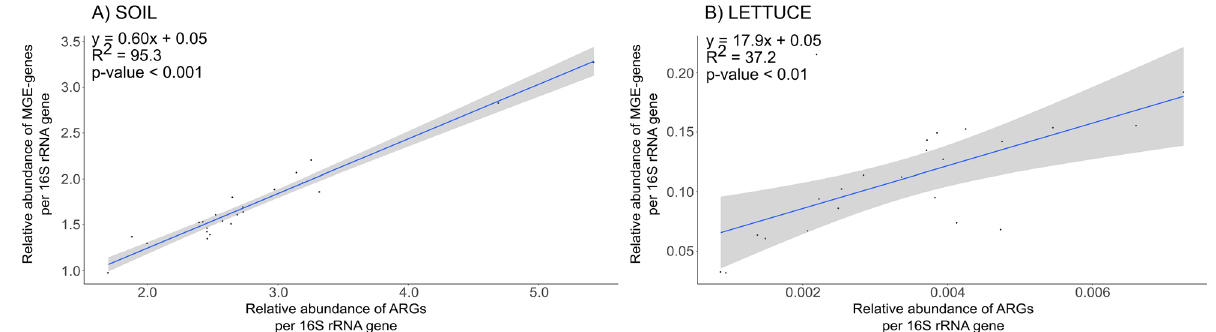
Figure 4. Results of the ordinary least squares (OLS) regression analysis of the relationship between the relative abundance of antibiotic resistance genes (ARGs) and mobile genetic element (MGE) genes in ( A ) soils and ( B ) lettuce plants. The line represents the best-fit curve. The shaded area represents the 95% confidence interval for the fitted OLS